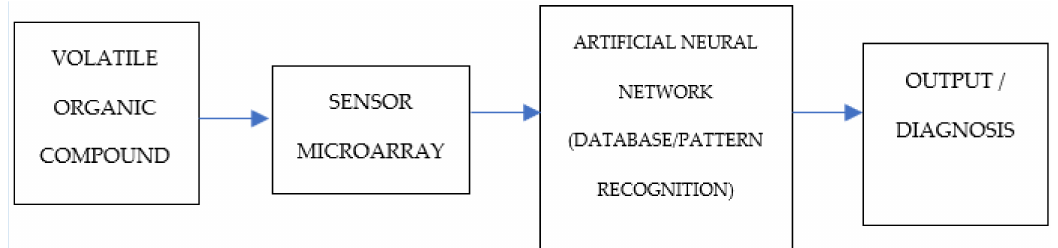
Figure 1. Schematic representation of an electronic